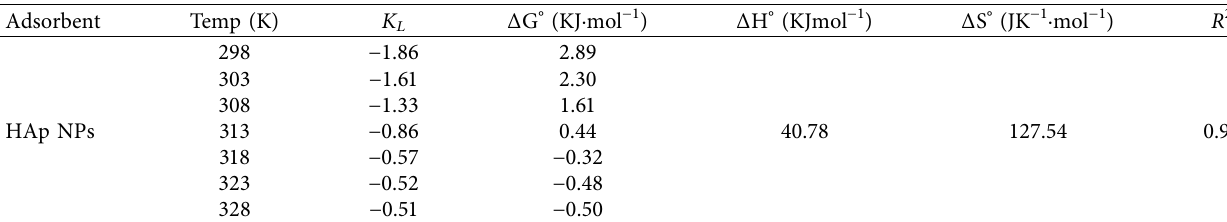
Table 5: Termodynamic parameters for fuoride ion adsorption on HAp NPs adsorbent.